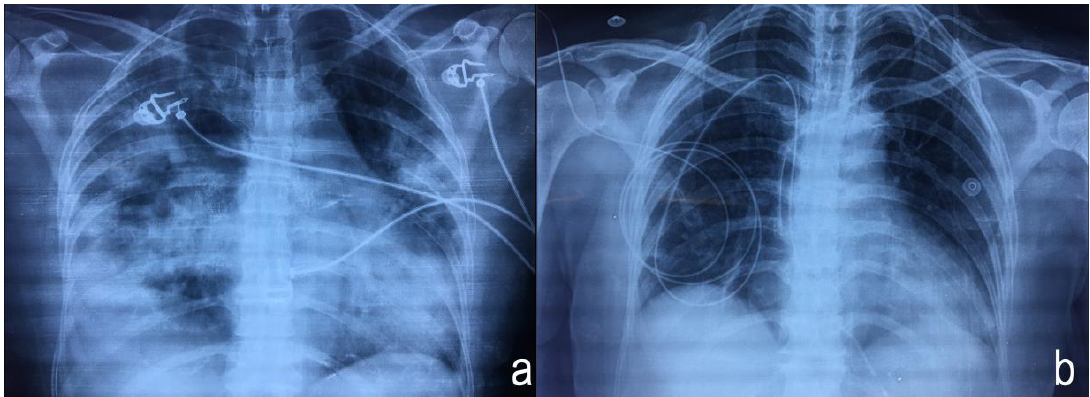
Figure 1. Electrocardiogram of the patient on admission to the emergency room. It shows a dissociation of P waves (V 1 Red arrows) from the QRS complexes.